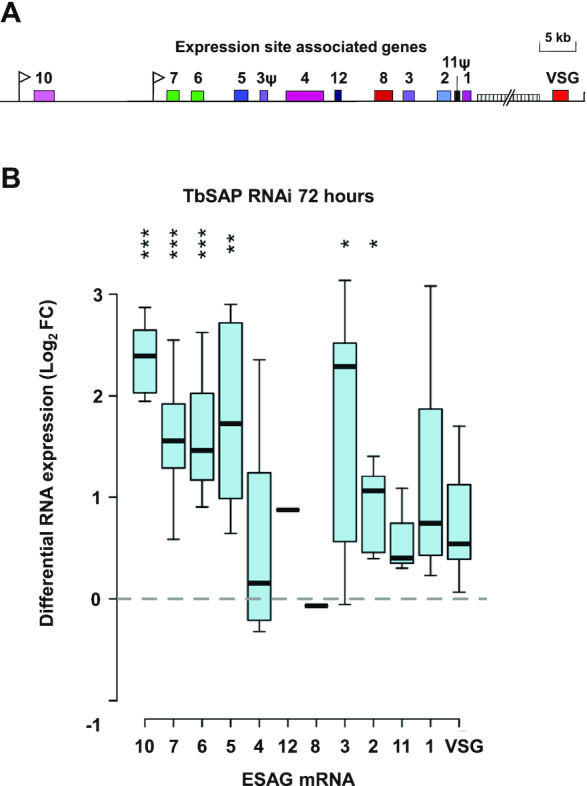
Differential upregulation of promoter proximal expression site associated genes (ESAGs) in bloodstream form expression sites (BESs) after the induction of TbSAP RNAi. (A) Schematic of a typical telomeric BES with promoters indicated with white flags and relevant expression site associated genes (ESAGs) or pseudogenes (ψ) with numbered coloured boxes (12). 70 bp repeat arrays are indicated with a vertically hatched box. (B) Differential regulation of ESAGs in inactive BESs following induction of TbSAP RNAi for 72 h. ESAGs have been arranged according to their common conserved position in T. brucei 427 BESs (12). A Tukey boxplot is shown with median (bar), interquartile range (box) and inner fences (whiskers) for all transcripts resulting from individual ESAGs of each family, excluding those of the active BES1. Only transcripts directed with MAPQ ≥2 at ≥1 reads per million reads are included (one transcript each of inactive ESAG12 and ESAG8 copies pass this threshold). Asterisks indicate Bonferroni-corrected P-values for individual transcript sets being different from 0 (Student's t-test; *** P≤ 0.001, ** P≤ 0.01, * P≤ 0.05).